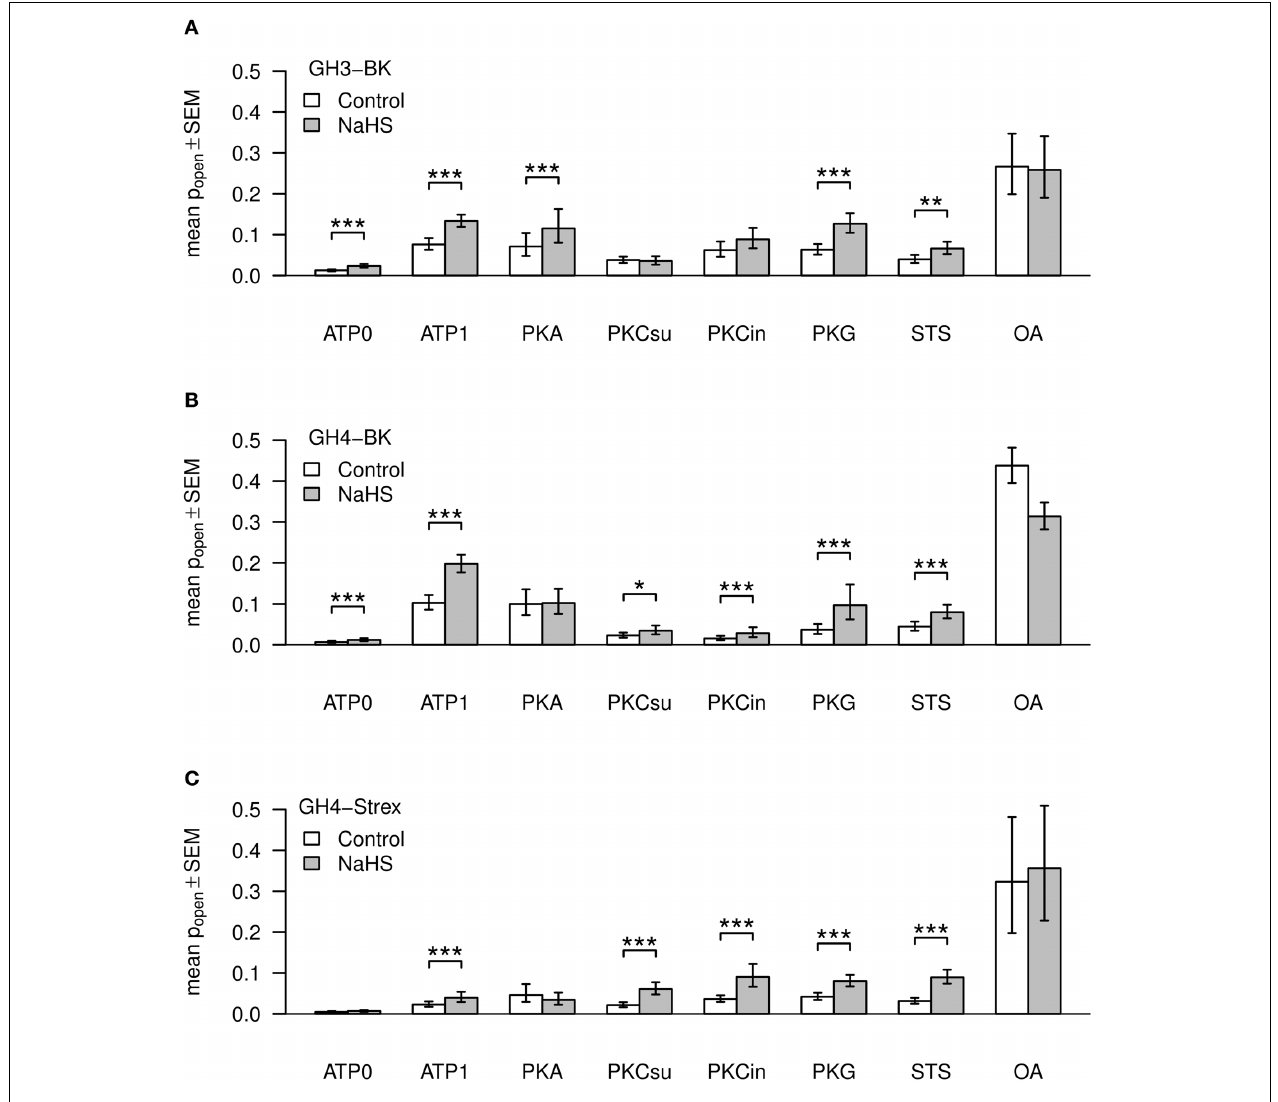
FIGURE 3 | Mean values of BK channel open time probabilities (P open ). Three types of channels, GH3-BK (A) , GH4-BK (B) , and GH4-STREX (C) cells, were investigated. Bar graphs show Po-values under control conditions (left bars, white) and after extracellular application of NaHS (right bars, gray). ATP, kinase, kinase inhibitor, kinase inhibitor staurosporine (STS), or phosphatase blocker okadaic acid (OA) were added